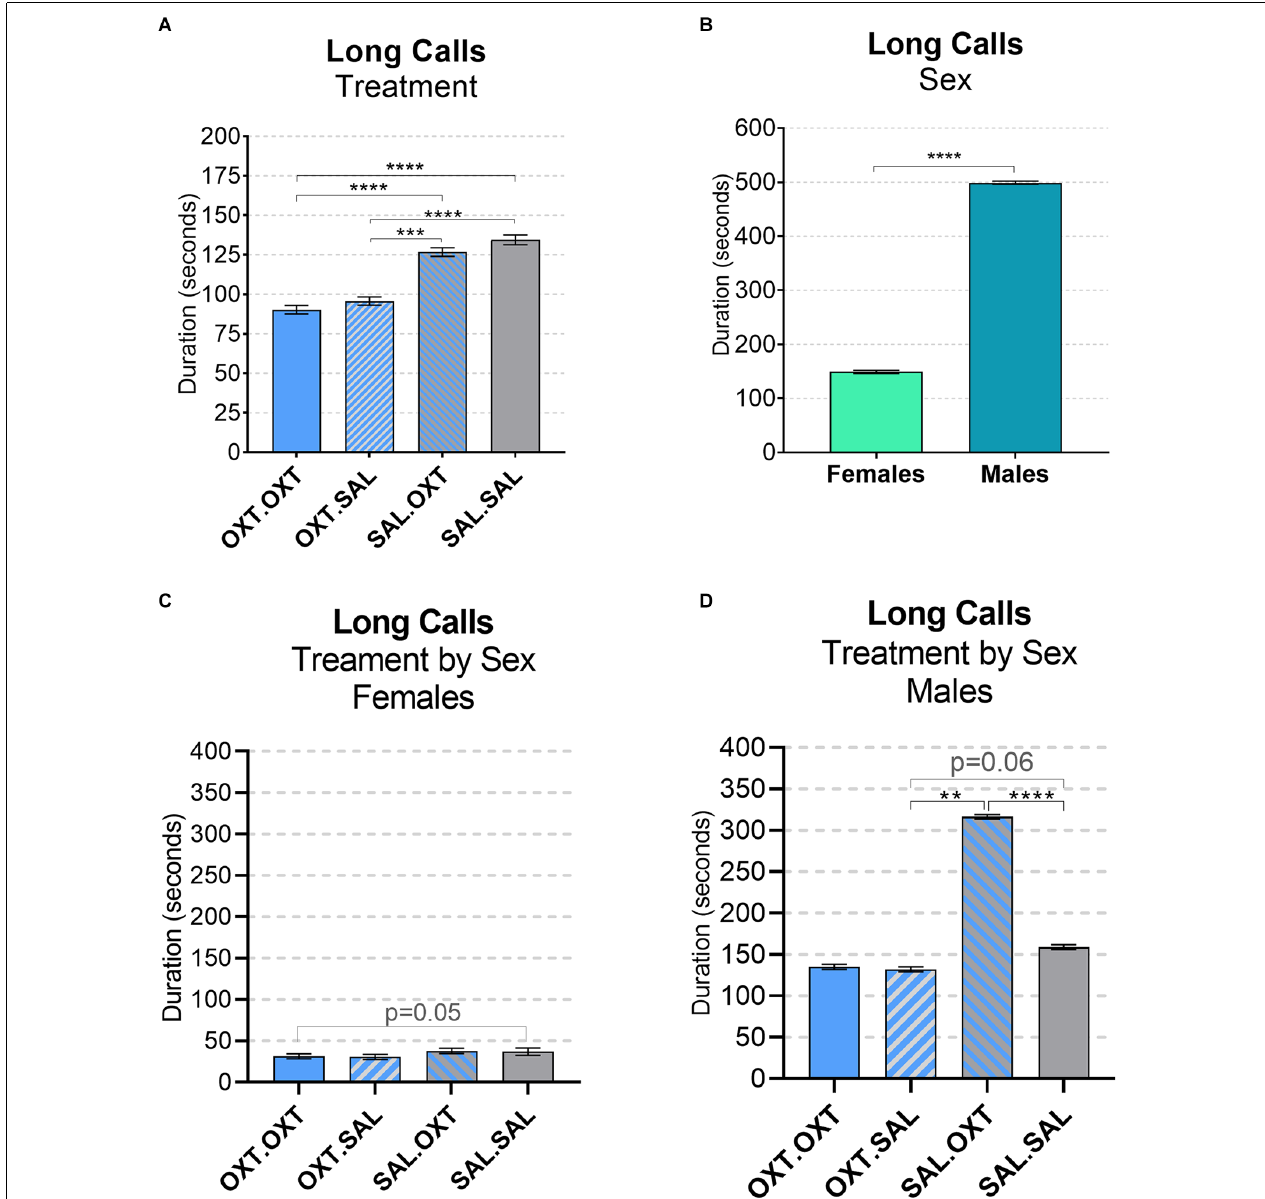
FIGURE 3 | Vocalizations: long calls. (A) Subjects from chronic OXT treatment groups (OXT.OXT and OXT.SAL) had a shorter duration of long calls than subjects from chronic SAL treatment groups (SAL.OXT and SAL.SAL). (B) Males had longer long call durations than females. (C) Non-significant trend for OXT. OXT females have shorter long calls than SAL.SAL females. (D) Males treated with SAL. OXT had a longer duration of long calls than males treated with OXT.SAL and SAL.SAL. Significance summary: ** p ≤ 0.01, *** p ≤ 0.001, **** p ≤